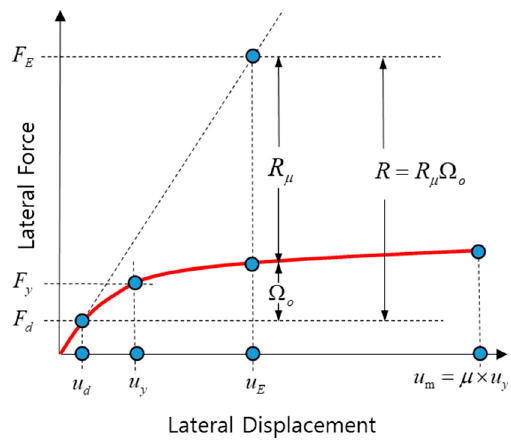
Figure 2. Response modification, overstrength and ductility.